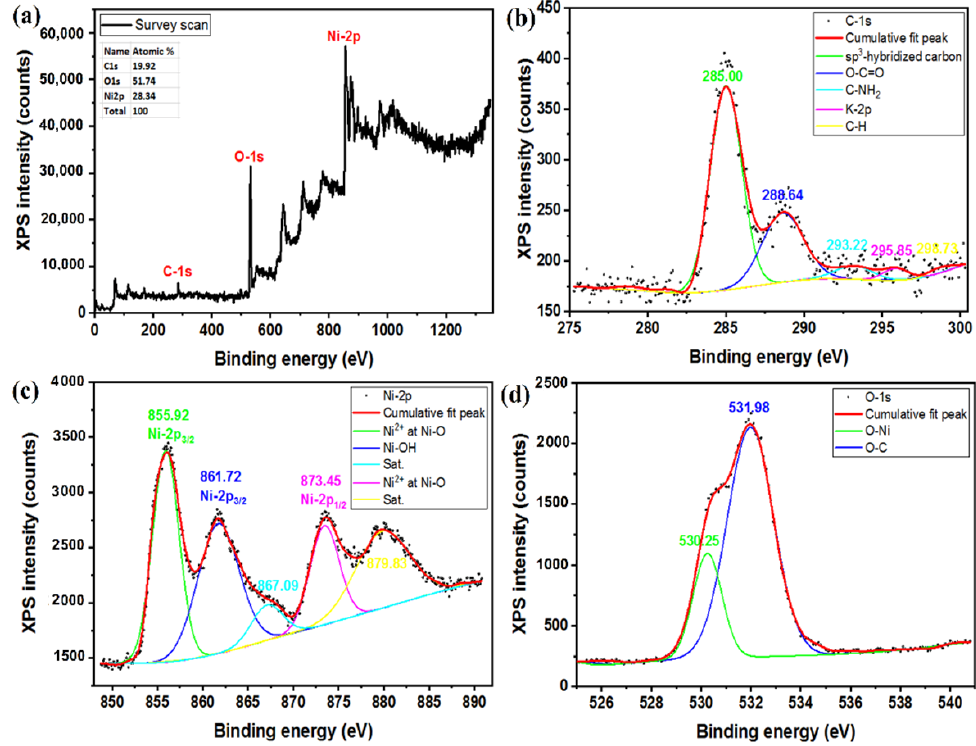
Figure 2. XPS of Ni@rGO substrate, ( a ) survey scan, ( b ) C-1 s , ( c ) Ni-2 p , and ( d ) O-1 s.